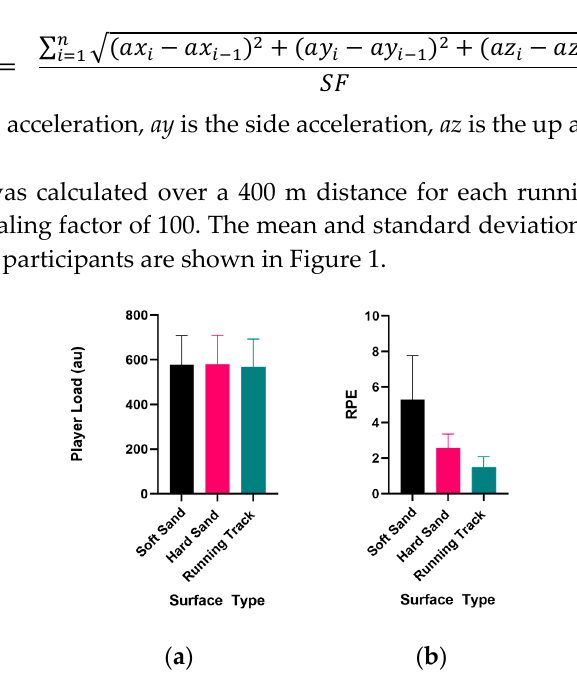
Figure 1. ( a ) Mean Player load (PL) and standard deviation bar calculated for each surface type; ( b ) Mean values of the self-assessed RPE and standard deviation bar calculated for each surface type.